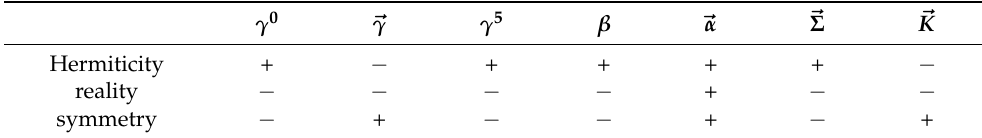
Table A1. Properties of gamma-matrices in Majorana representation. We define as usual γ 0 = β and (cid:126) γ = β (cid:126) α from Dirac’s Hamiltonian; γ 5 = i γ 0 γ 1 γ 2 γ 3 as the chirality matrix; Σ of Lorentz’s group: Σ 1 = Σ 23 , Σ 2 = Σ 31 , Σ 3 = Σ 12 (spin), and (cid:126) K = i γ 0 (cid:126) γ = i (cid:126) α (boost). The indices i , j , k take the values